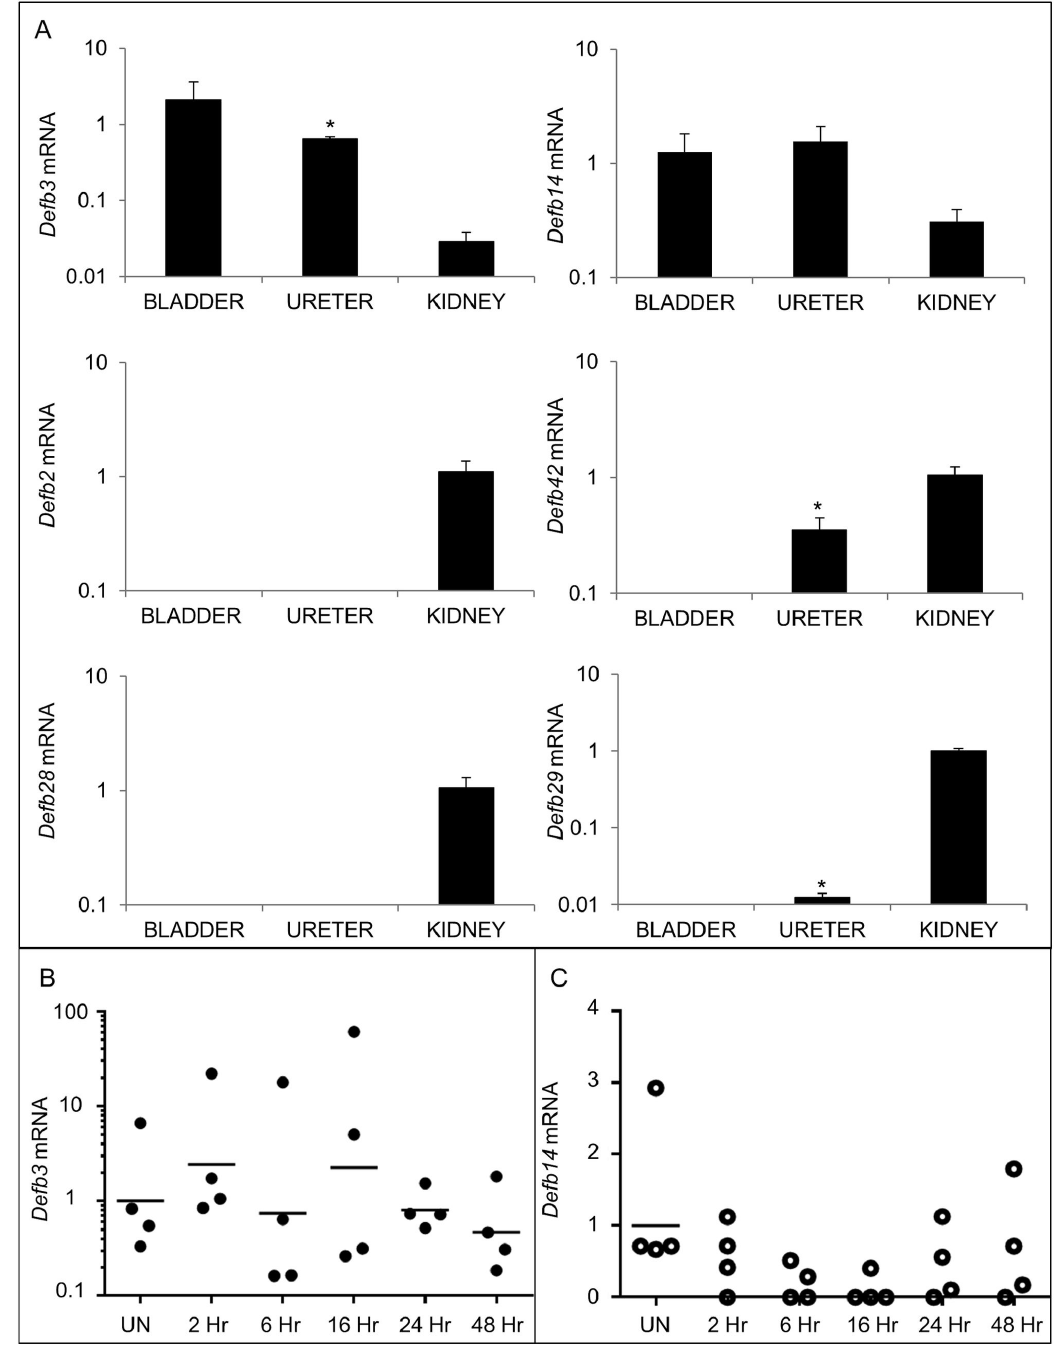
Figure 4. Additional BDs are expressed in the lower urinary tract. (A) Expression of Defb mRNAs in uninfected kidneys, ureters, and bladders. Samples were normalized for Gapdh content and compared to a pool of uninfected bladder cDNA using the 2^-ΔΔCT method[22]. Means ± S.E.M. are shown from 4 bladders, ureters, and kidneys. * indicates p < 0.05 in a 2-tailed Student’s t -test comparing the indicated organ to kidney. (B) Defb3 and (C) Defb14 mRNA expression in bladder following UPEC infection. Time in hpi is indicated on the X axis. All samples were normalized for Gapdh content and compared to a pool of uninfected bladder cDNA using the 2^-ΔΔCT method[22]. The horizontal line indicates the geometric mean for each timepoint. Samples on the X-axis had undetectable Defb14 mRNA expression. (n=4 animals/group; Student’s 2-tailed t -test, p > 0.05 for all comparisons of uninfected versus infected timepoints). doi: 10.1371/journal.pone.0077714.g004 PLOS ONE |